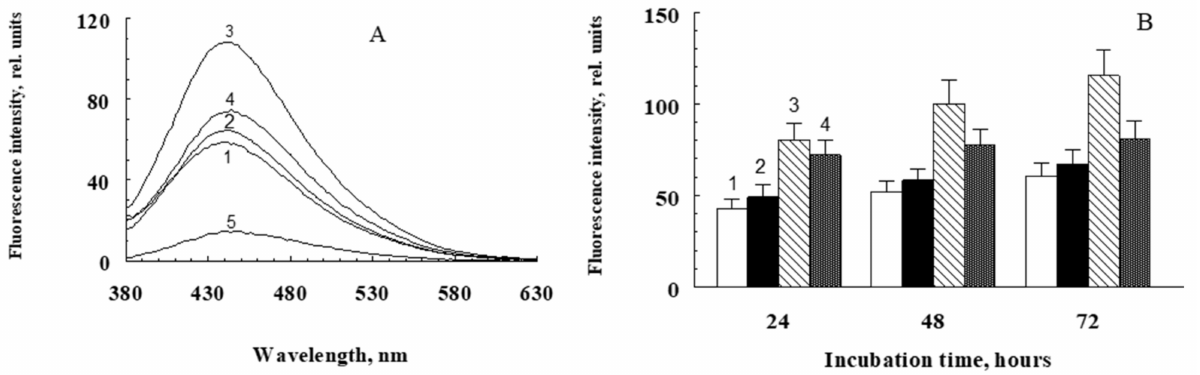
Figure 5. Modification of BSA by water-soluble products obtained by irradiation of A2E solubilized with silica gel. ( A ) Comparative fluorescence spectra of modified BSA after 72 h of incubation at 37 ◦ C. ( B ) The kinetics of BSA fluorescence increased during its modification with water-soluble products of A2E photodestruction (SUPA2E-Si preparation). Data are means of three assays. The incubation medium contained 0.1 M K-phosphate sterile buffer and 3 mM sodium azide.